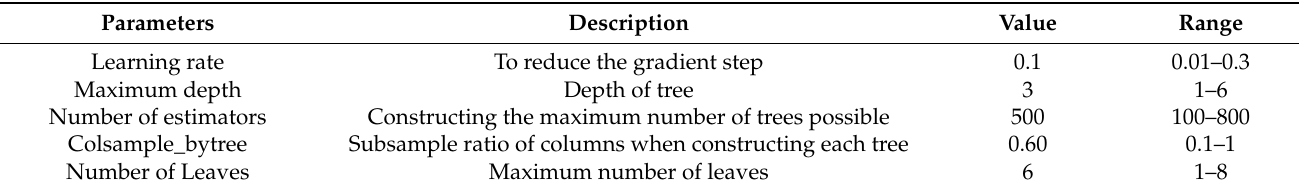
Table 3. Tuned or optimized hyperparameters of LIGHT